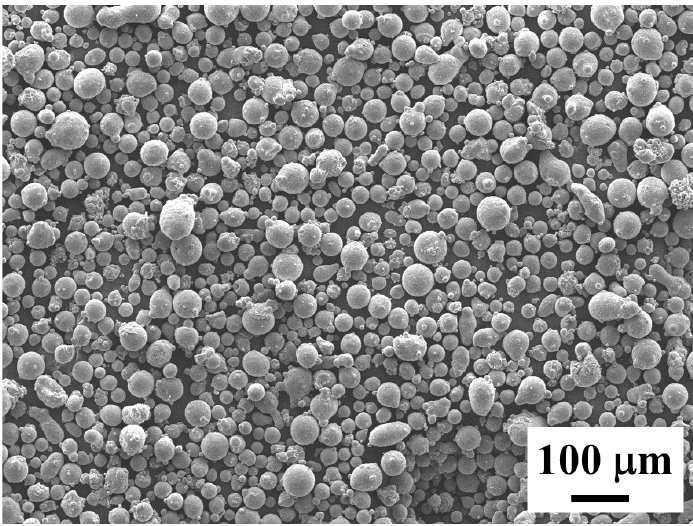
Figure 1. The SEM image of the pre-alloyed Scalmalloy powders. Table 1. Summary of the 3D printing parameters used in this